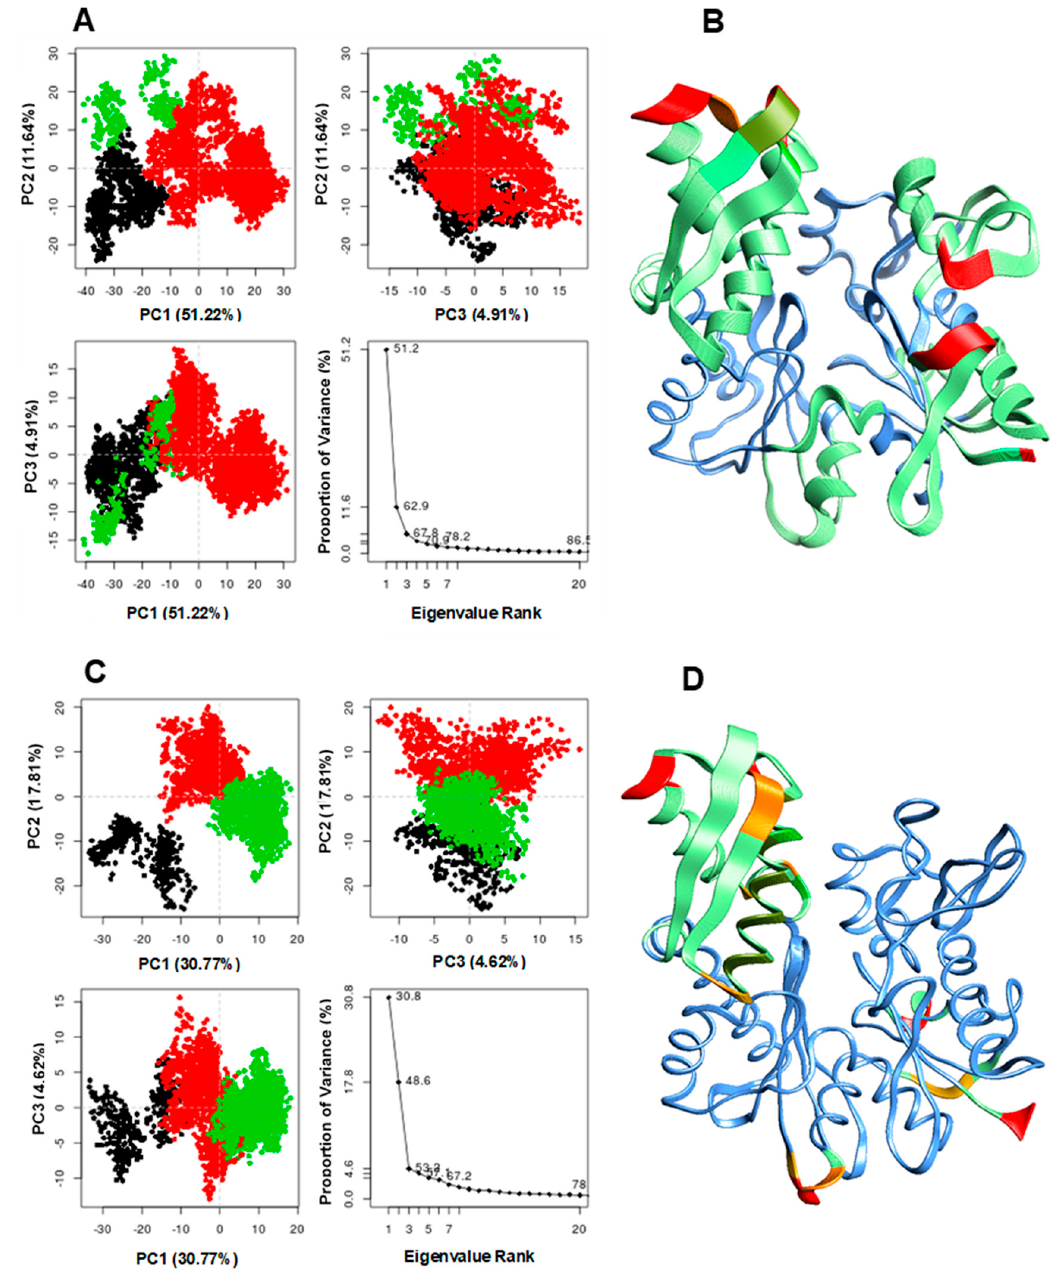
Figure 7. Clustering and principal component analysis on 250ns of equidistance conformations using the Bio3D package in R. The plots show the first three eigenvectors for Cys-17 HSP72 complex ( A ) and Lys-56 HSP72 complex ( C ) Conformers are colored according to the k-means clustering: cluster 1, black; 2, red; 3, green. dominant motions and captured eigenvector variance; and residue mobility for Cys-17 HSP72 complex ( B ) and Lys-56 sHSP72 complex ( D ). The color scale from blue, green, to red depicts low to high atomic displacements.